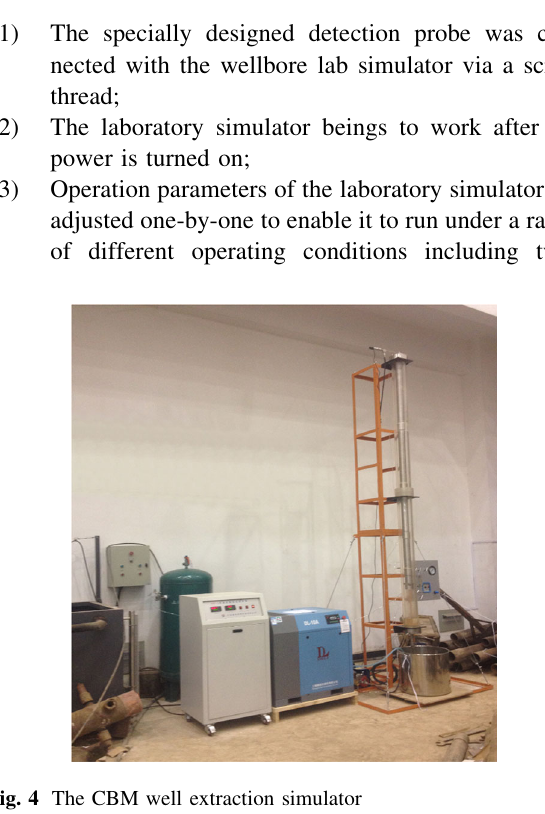
Fig. 4 The CBM well extraction